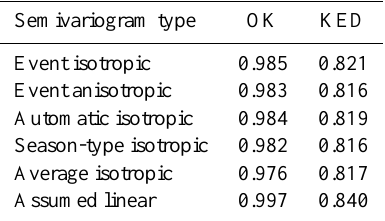
Table 4. Interpolation performance from cross-validation of the var- ious variogram types with respect to RMSE criterion, averaged over all events and time steps exceeding a threshold of 1.0mmh − 1 of av- erage